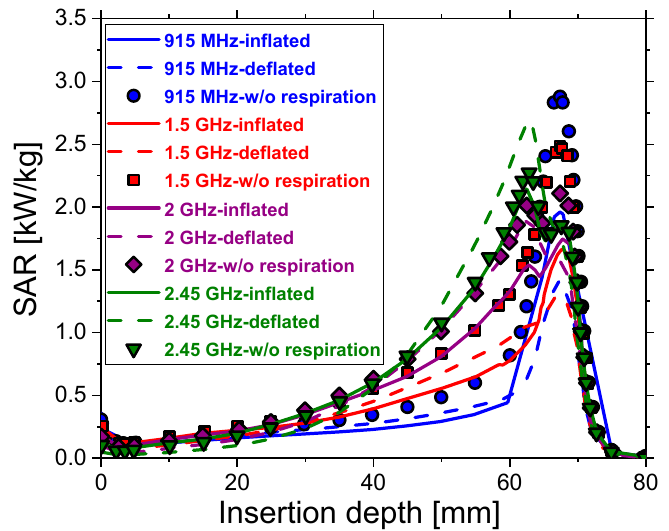
Figure 10. Axial profile of the specific absorption rate (SAR) during inflation (solid curves), deflation (dash curves), and regardless of respiration (symbols) at microwave frequencies in the range of 915 MHz to 2.45 GHz.